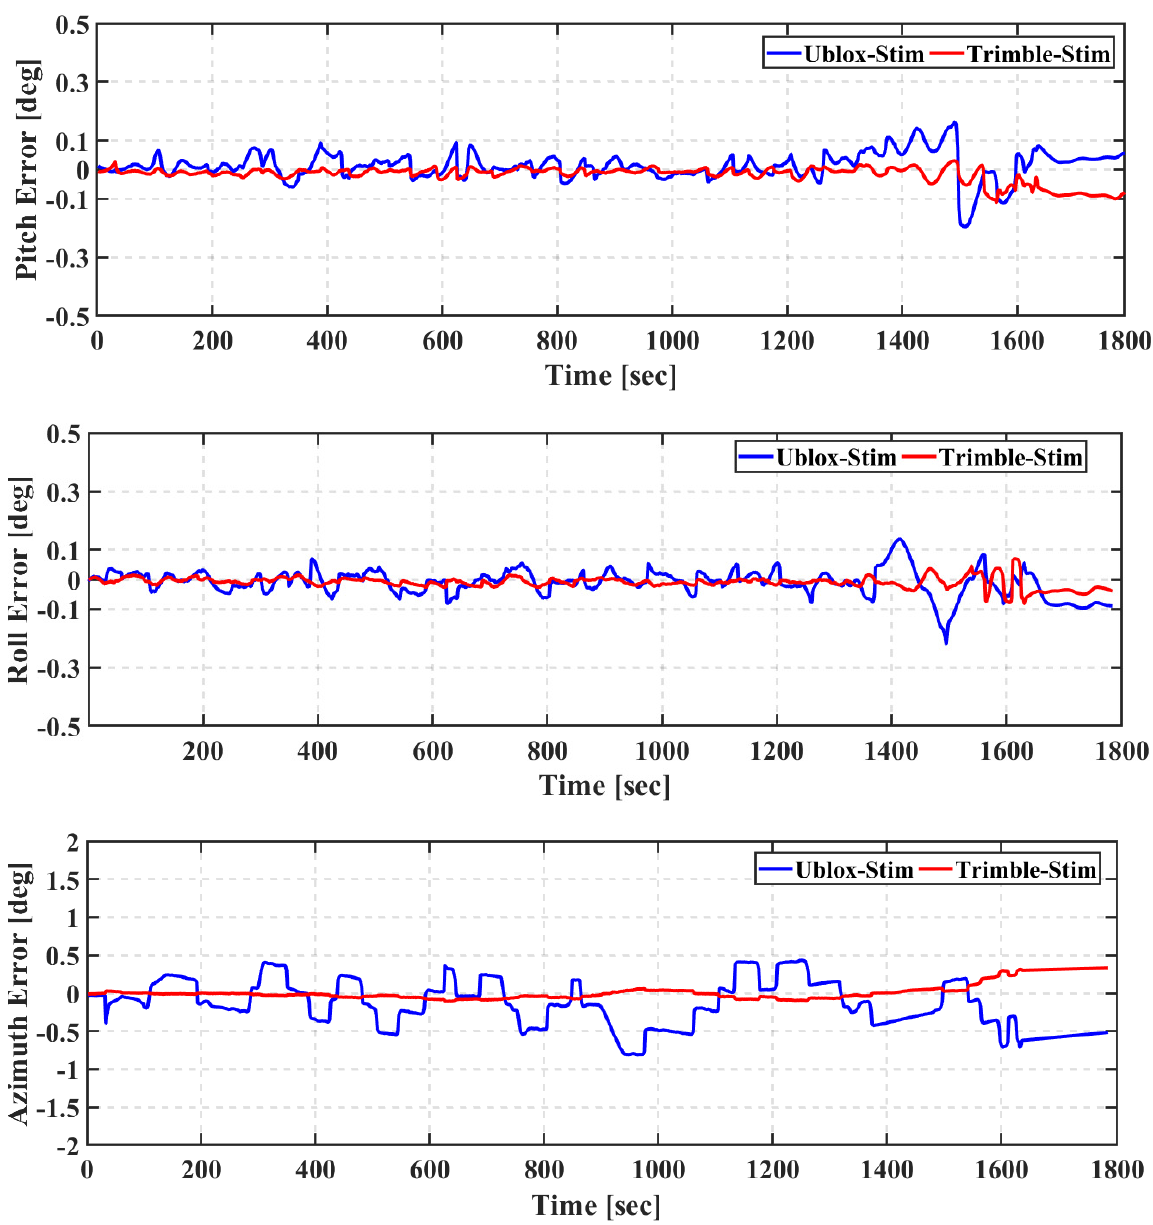
Figure 9. First field trial: Pitch ( top ), roll ( middle ), and azimuth ( bottom ) of real-time TC GNSS PPP/INS for Ublox–Stim and Trimble–Stim solutions. Table 4. RMS error and mean error (deg) of roll, pitch, and azimuth angles—first field trial.